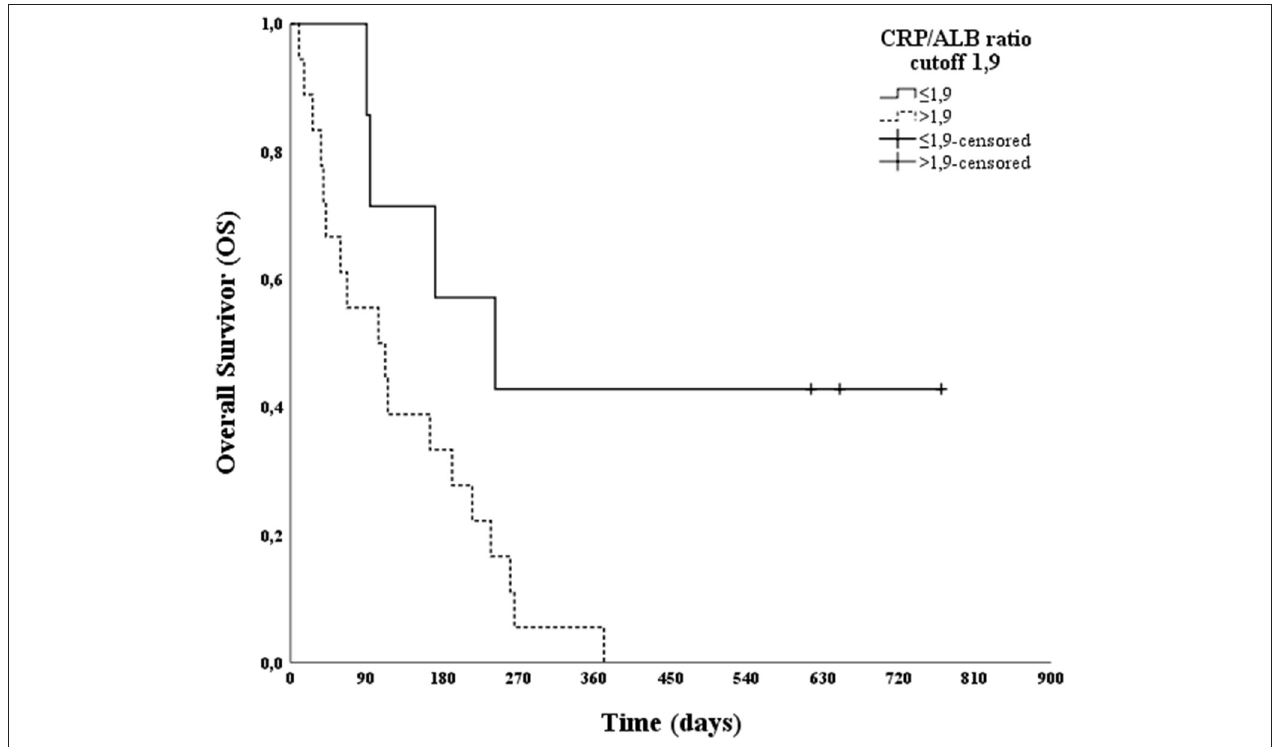
FIGURE 3 | Kaplan–Meier overall survival (OS) curve according to the C-reactive protein/Albumin (CRP/ALB) ratio cut-off point (1.9) in 25 canine patients with oral